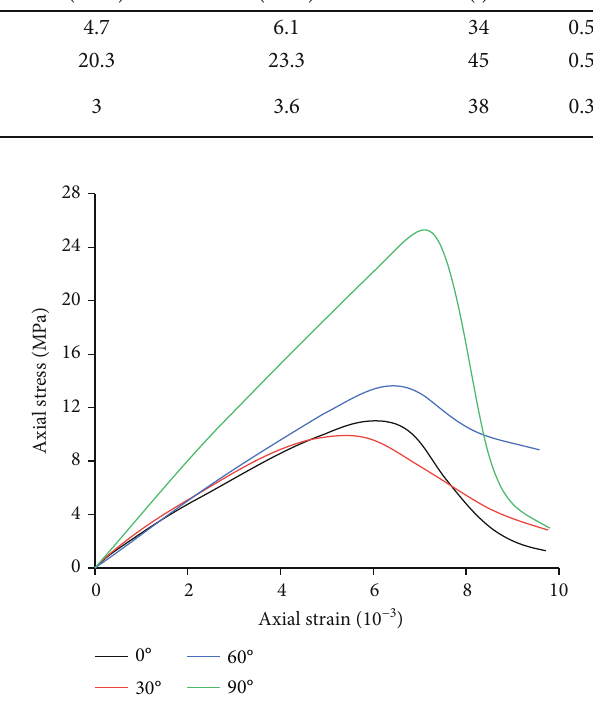
Figure 2: Simulated stress-strain curves under uniaxial